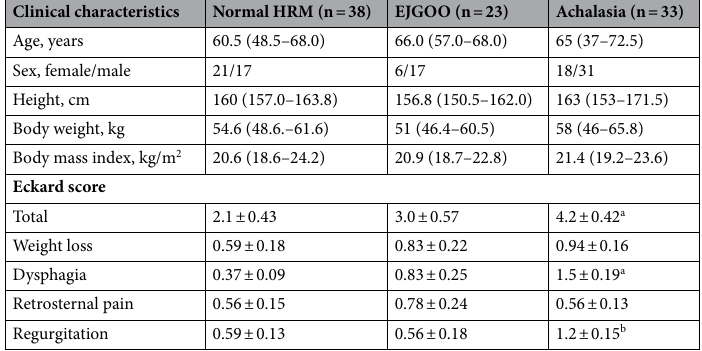
Table 1. Clinical characteristics of the patients with normal HRM and patients with EGJOO and Achalasia. EGJOO esophagogastric junction outflow obstruction; HRM high-resolution manometry. Results are shown as the median (interquartile range) or mean ± standard error. a p < 0.05 vs. Normal HRM. b p < 0.05 vs.